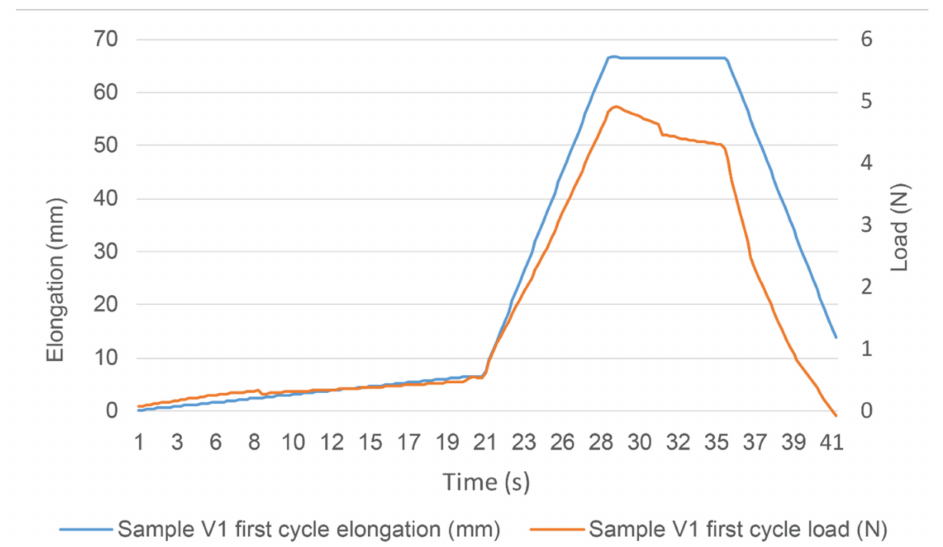
Figure 3. The tensile test one cycle overview, repeated 100